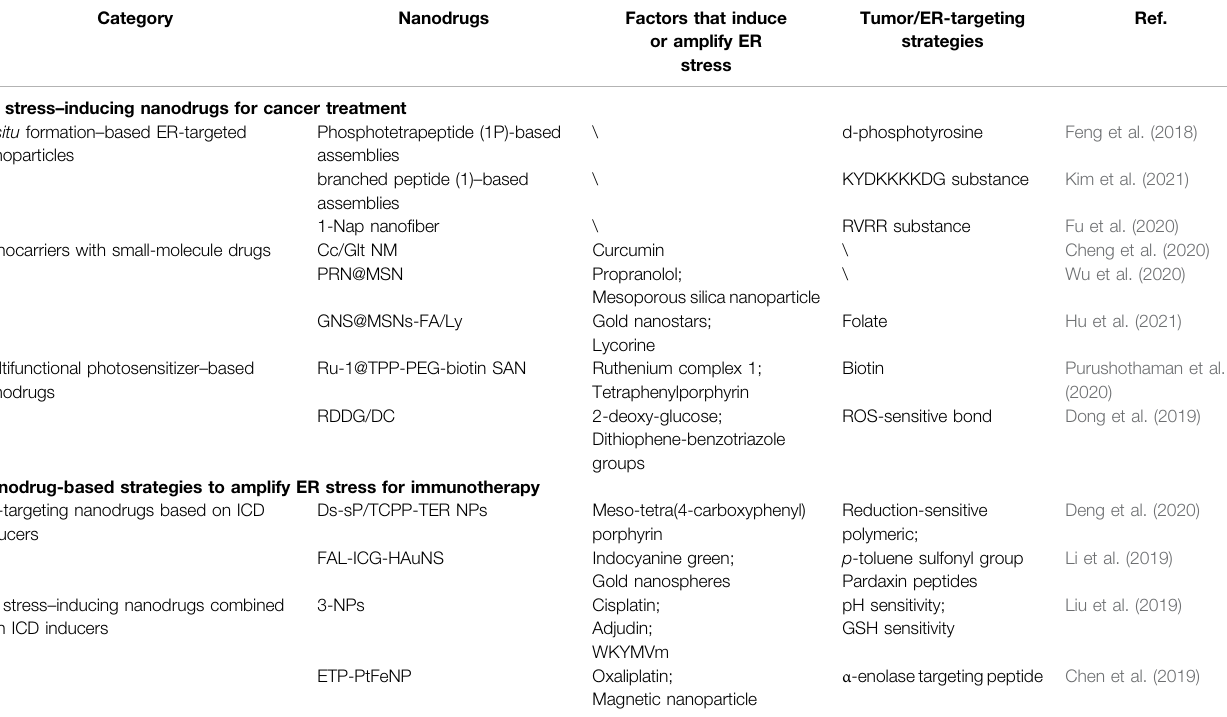
TABLE 1 | Nanodrugs manipulating ER stress for highly effective antitumor